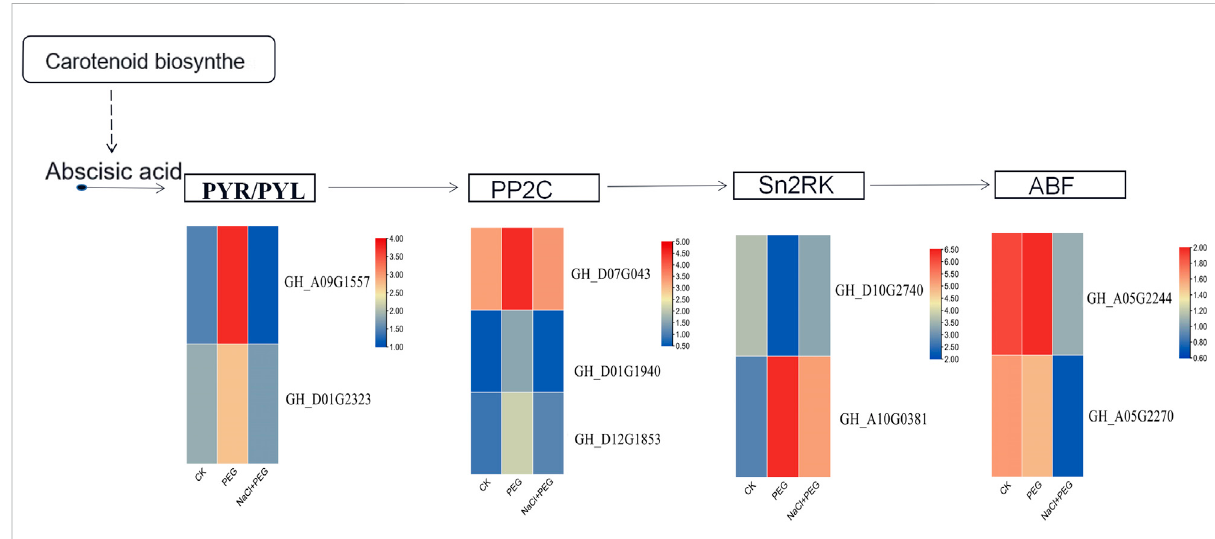
FIGURE 8 Changes in expression pro fi les of ABA downstream-related genes under three